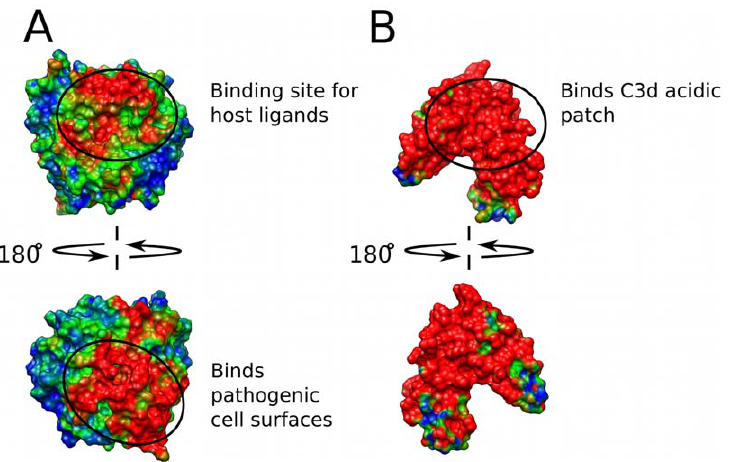
Figure 3. Conservation of electrostatic potential for homologues of C3d and CR2. (A) Cumulative electrostatic similarity distribution for 24 homologues projected onto the surface of human C3d. (B) Cumulative electrostatic similarity distribution for 4 homologues projected onto the surface of human CR2. The color transitions from blue – green – red when going from low to high similarity, and corresponds to ESI values of 2 0.10– 0.15–0.40.